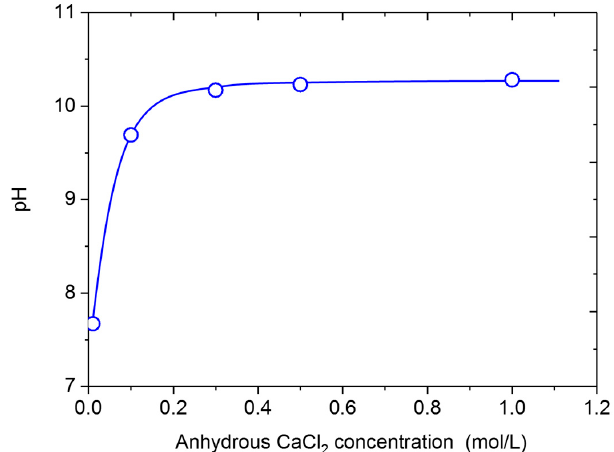
Figure 1. Effect of anhydrous CaCl 2 concentration on solution pH.